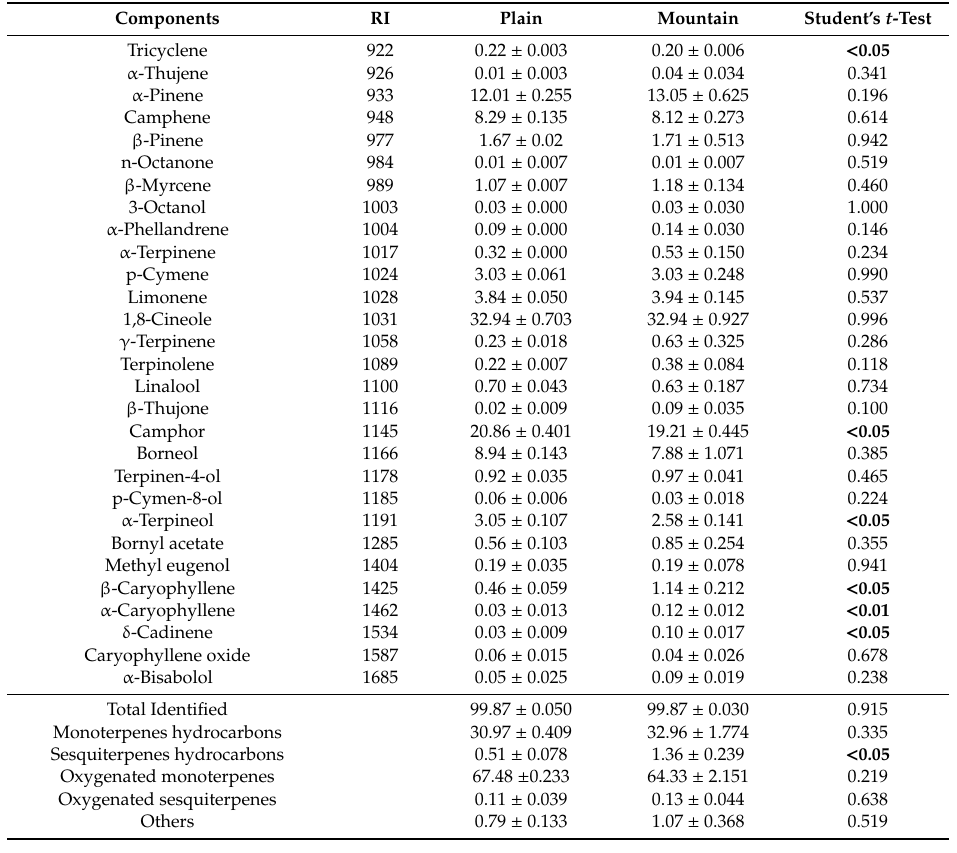
Table 8. Chemical composition (%) of essential oils of rosemary plants grown at di ff erent altitudes (plain vs. mountain). Data are expressed as means ± SE (n = 3), and significant di ff erences ( p < 0.05, p < 0.01, p < 0.001) in bold expressed between treatments are indicated by Student’s t -test p -values.